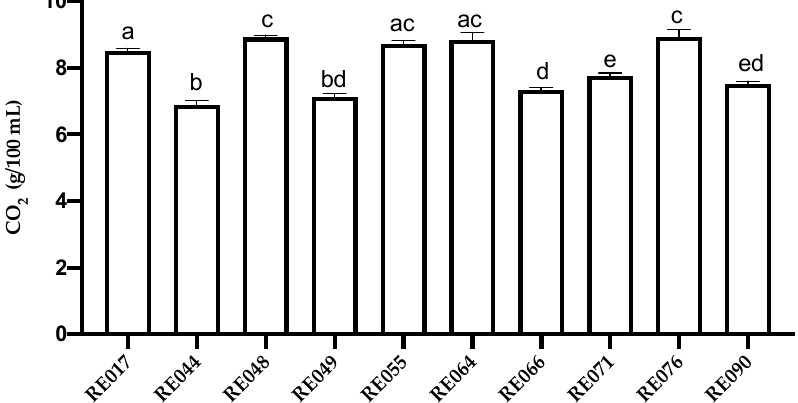
Figure 2. Ochratoxin A (OTA) reduction (%) obtained with the S. cerevisiae strains which passed the previous trials. The asterisk indicates significant differences at 95% of confidence level ( p < 0.05) between strains RE049 and RE064. Bars indicate ± standard deviation.